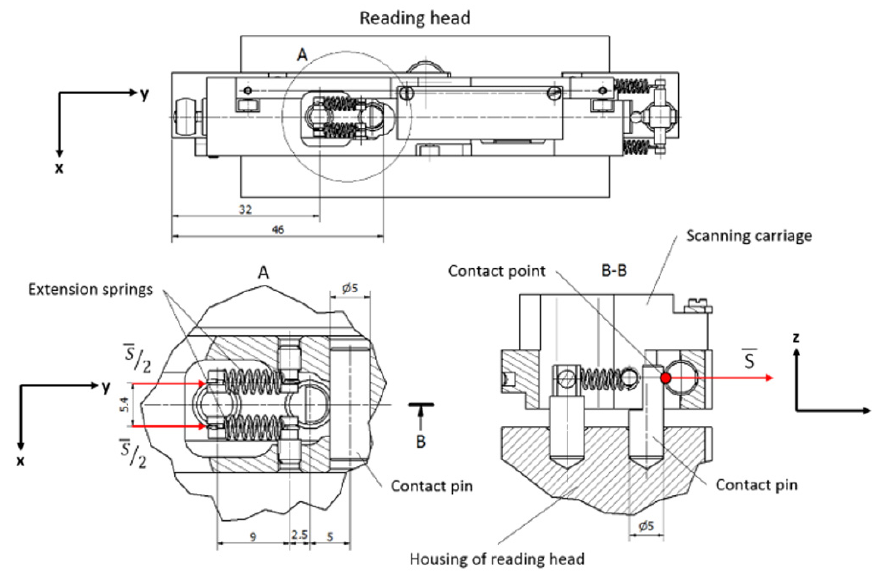
Figure 9. Mechanical construction of contact pair B.